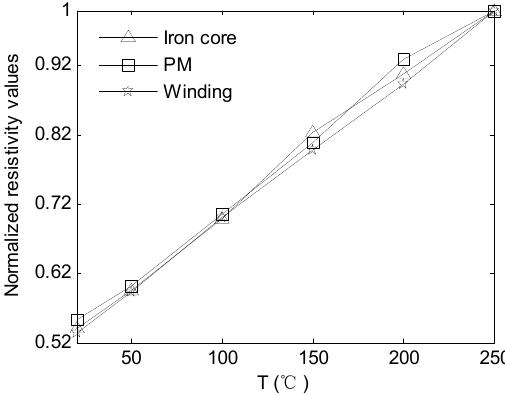
Figure 4. The resistivity curve changes with temperature.